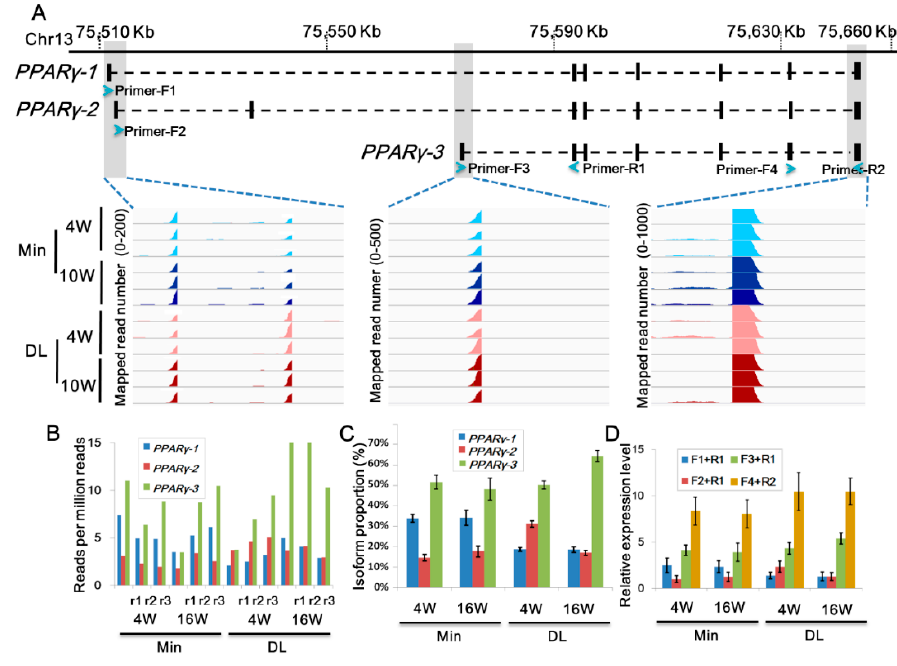
Figure 6. PPAR γ promoter usage in the DL and Min pigs. ( A ) The assembled exon structures of PPAR γ in pigs. Peaks show RNA-seq reads mapped to genomic regions in each pig breed at 4 weeks (4W) and 16 weeks (16W) of age ( n = 3 biological replicates). ( B ) Read number mapped to the first exon of each PPAR γ isoform. Read number was normalized by reads per million reads (RPM). ( C ) PPAR γ promoter usages. PPAR γ transcript isoform proportions were calculated by dividing the read number mapped to each first exon by the total read number mapped to all three first exons. ( D ) Expression level verification by qRT-PCR. Blue arrows in A give the exon regions used to design the qRT-PCR primers. Data presented with standard error bars per group ( n = 3).